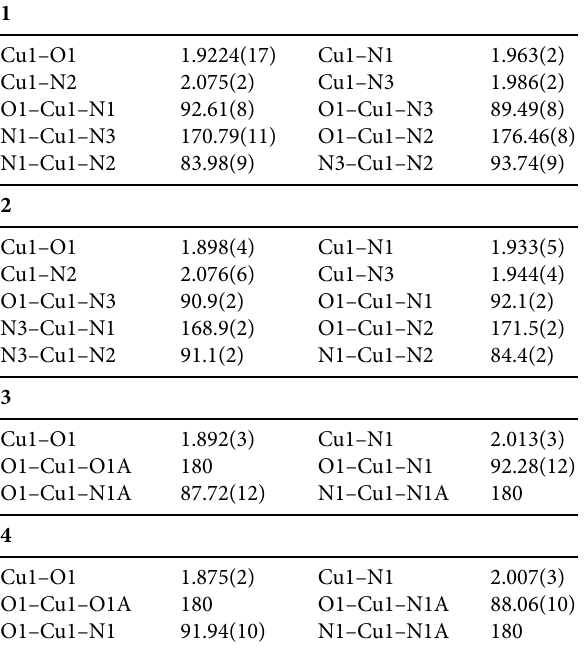
Table 2. Selected bond distances (Å) and angles (°) for the